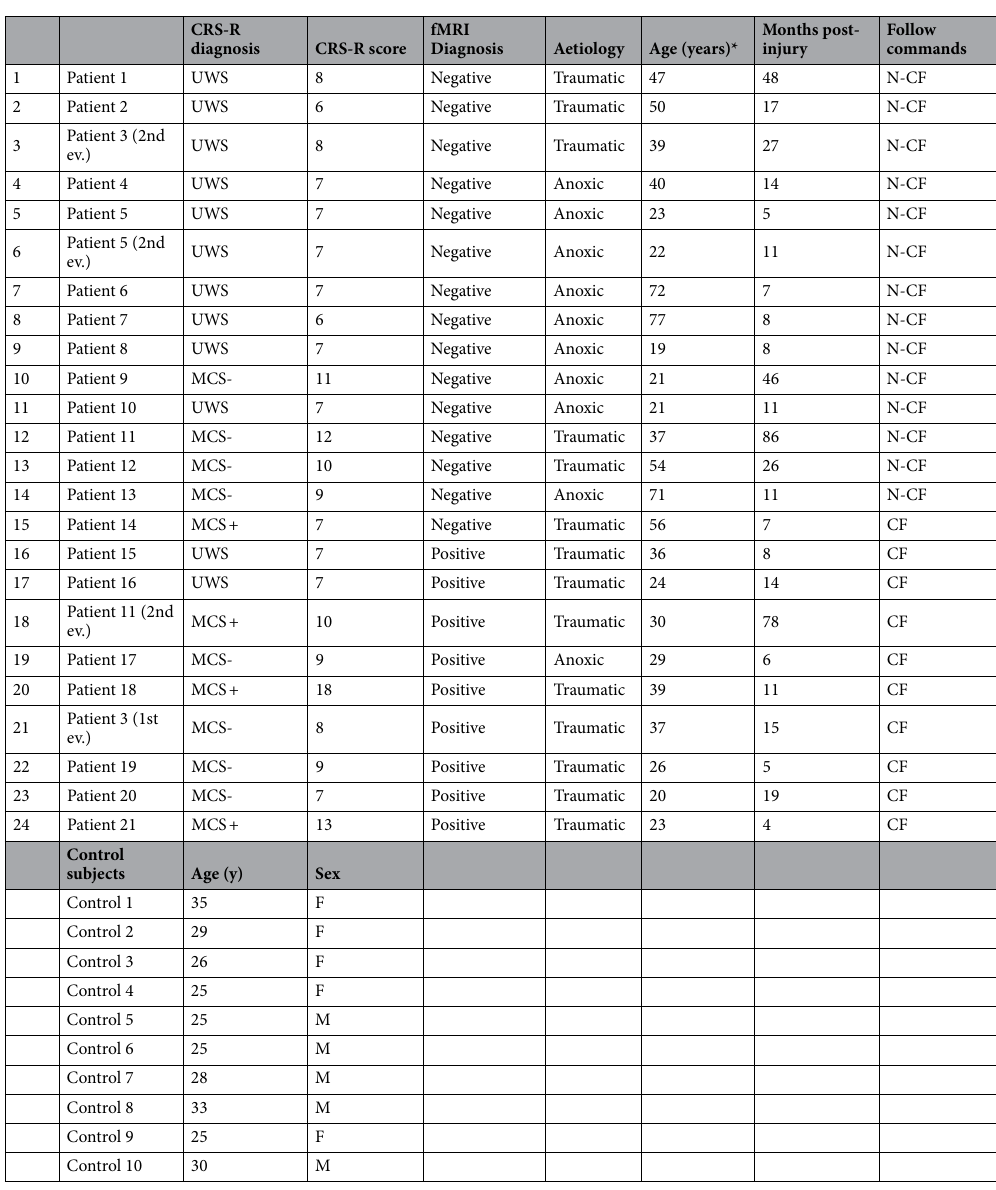
Table 1. Main features of DoC group. *At the moment of EEG